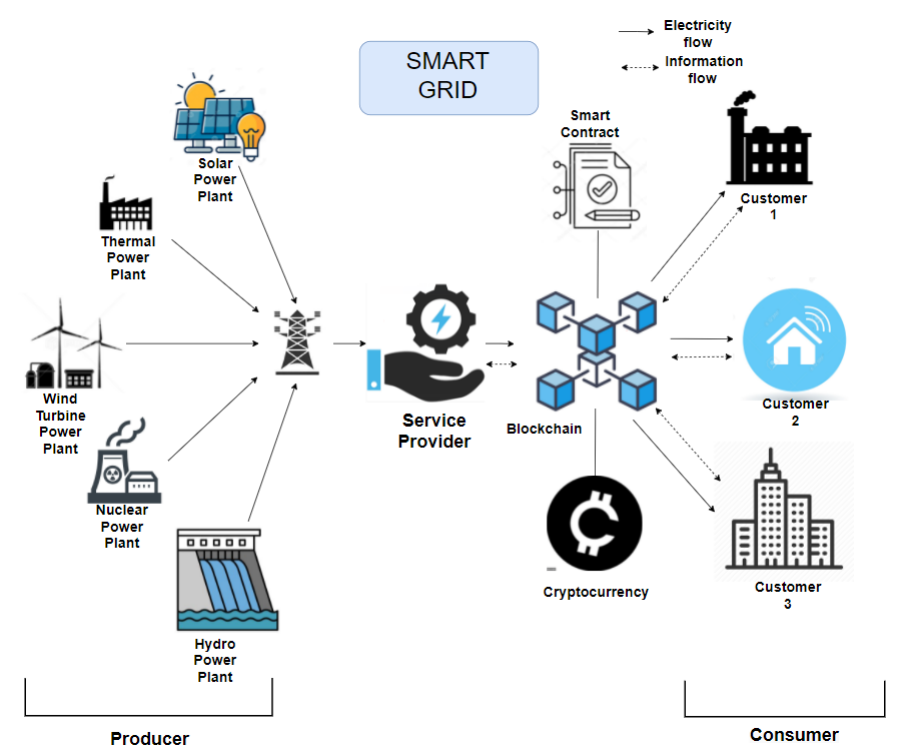
Figure 1. System model of blockchain-based Stackelberg smart grid